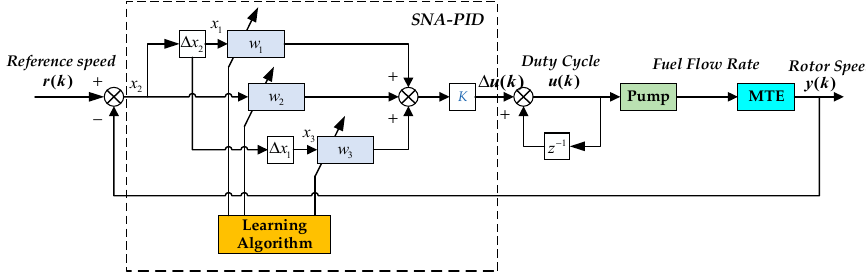
Figure 7. Block diagram of MTE system with single neural adaptive proportional–integral–derivative (SNA-PID) controller.